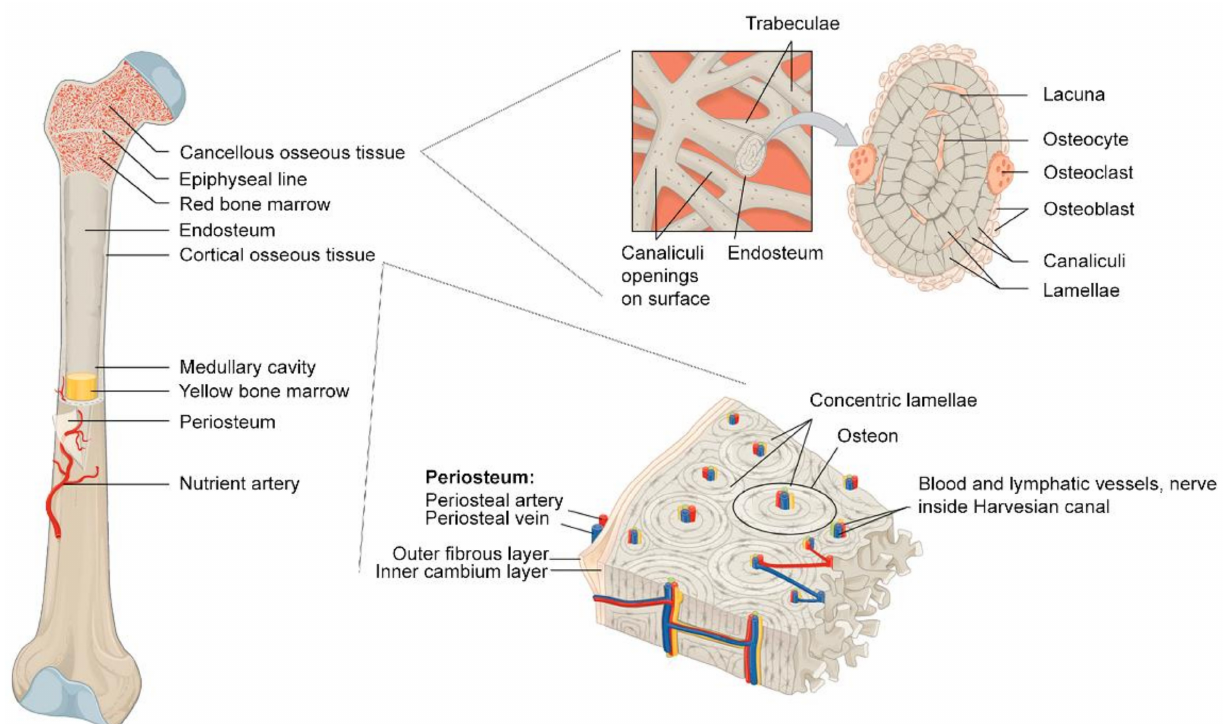
Figure 1. Schematic image of bone anatomy. Reprinted with permission from Ref. [47].